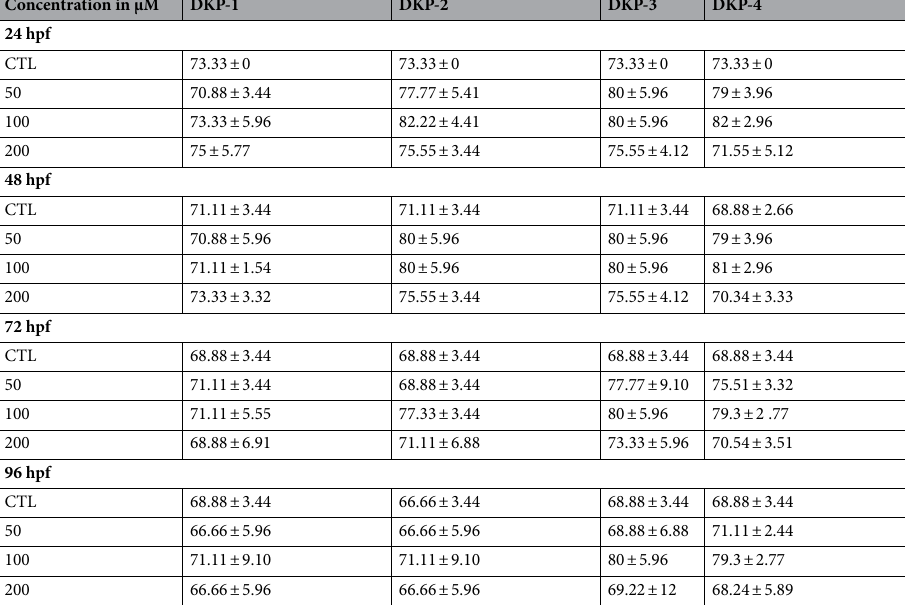
α [ α ] t = D cl where α = observed rotation, c = concentration (g/mL), l = length of cell (dm), D = yellow of light from sodium lamp, and t = temperature (Celsius). cell culture. Human colorectal cancer (HT-29) and mouse embryonic fibroblast (3T3) cells were obtained from the American Type Culture Collection Centre (ATCC, VA, USA). Both cells were grown in Dulbecco Mod- ified Eagle’s Medium (DMEM, HiMedia, India) supplemented with 10% heat-inactivated fetal bovine serum (FBS), penicillin (50 units/mL), and streptomycin (50 µg/mL) and were cultured at 37 °C, 5% CO 2 in a humidi- fied atmosphere. Cell viability by the MTT assay.